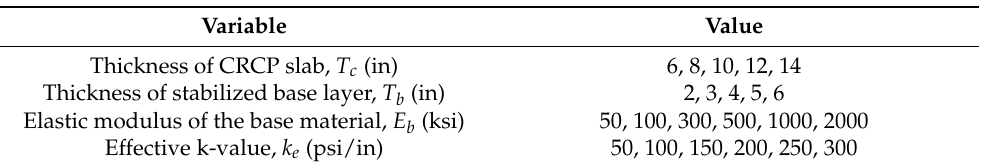
Table 11. Independent variables and values for FE analysis of the CRCP structure (1 in = 25.4 mm, 1 ksi = 6.89 MPa, 1 psi/in = 271 kN/m 3